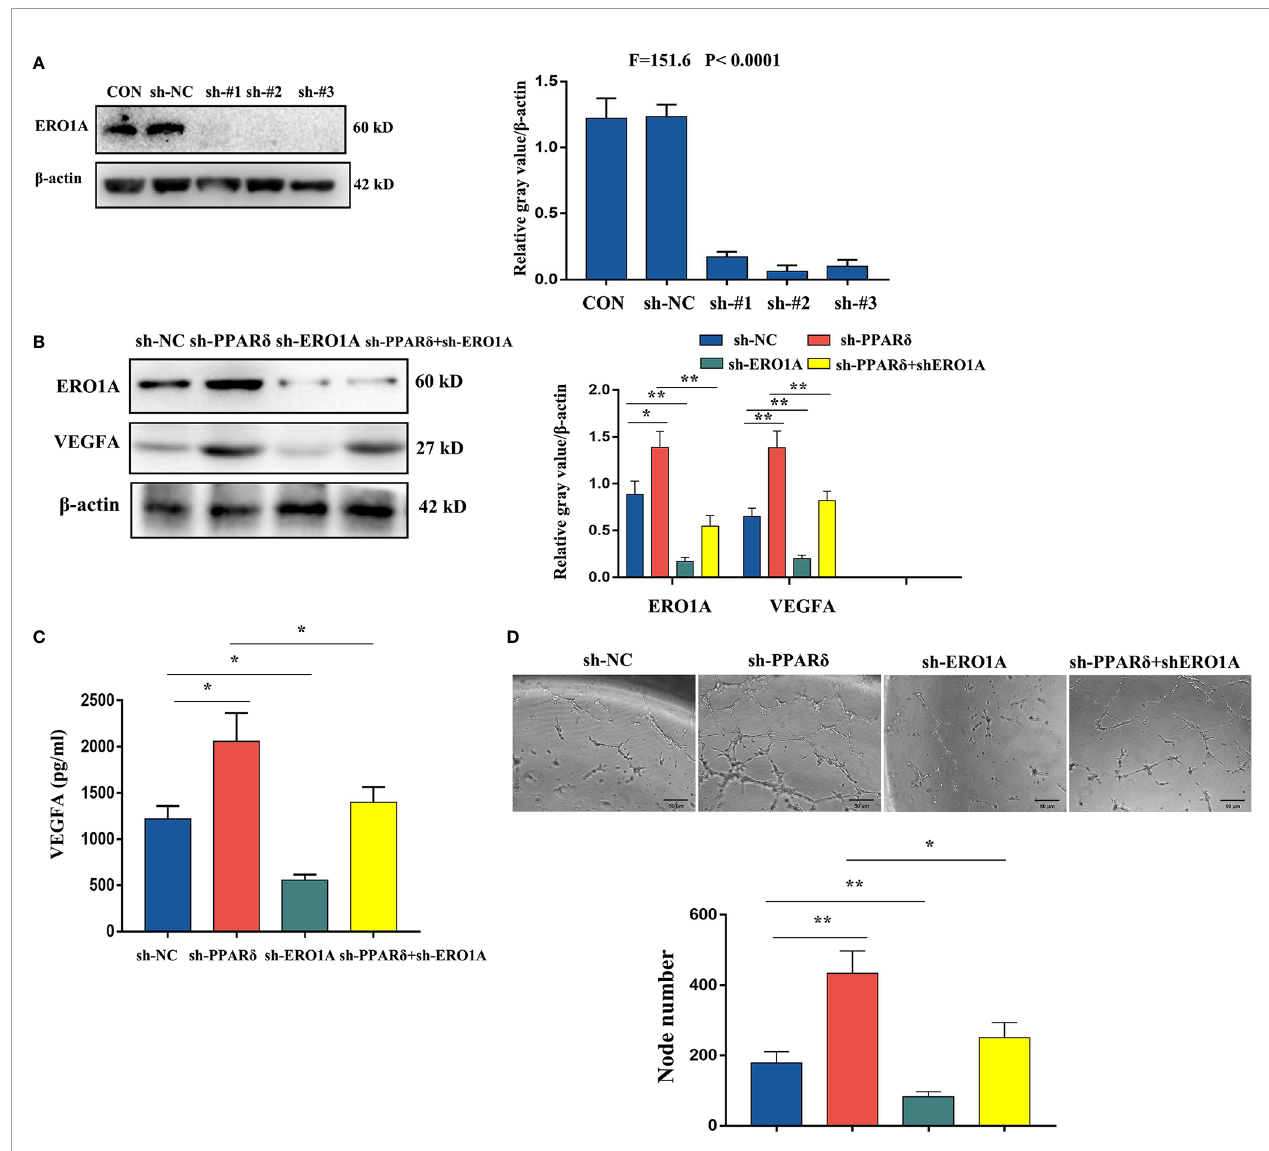
FIGURE 6 | Knockdown of PPAR d promotes VEGFA expression via ERO1A. (A) Veri fi cation of PPAR d and ERO1A codepletion as measured by Western blot analysis. (B) The expression of ERO1A and VEGFA in CRC cells as detected by Western blot analysis. (C) VEGFA secretion in conditioned medium of HCT116 cells overexpressing both PPAR d and ERO1A as detected by ELISA. (D) HUVEC tube formation images in the four groups. The number of tubes shows the angiogenesis ability in all groups. Scale bars, 50 m m (magni fi cation, 400×). The results represent the means ± SD from three separate experiments, *P < 0.05, **P <